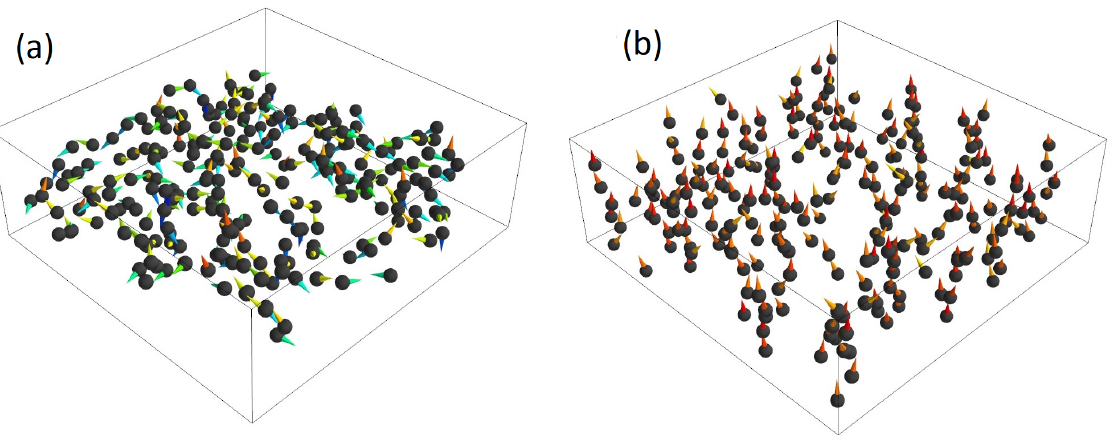
Figure 5. Three-dimensional elastomer-magnetic particle system, the color is associated with the z-component of spin. ( a ) System before applying magnetic field . ( b ) System after applying magnetic